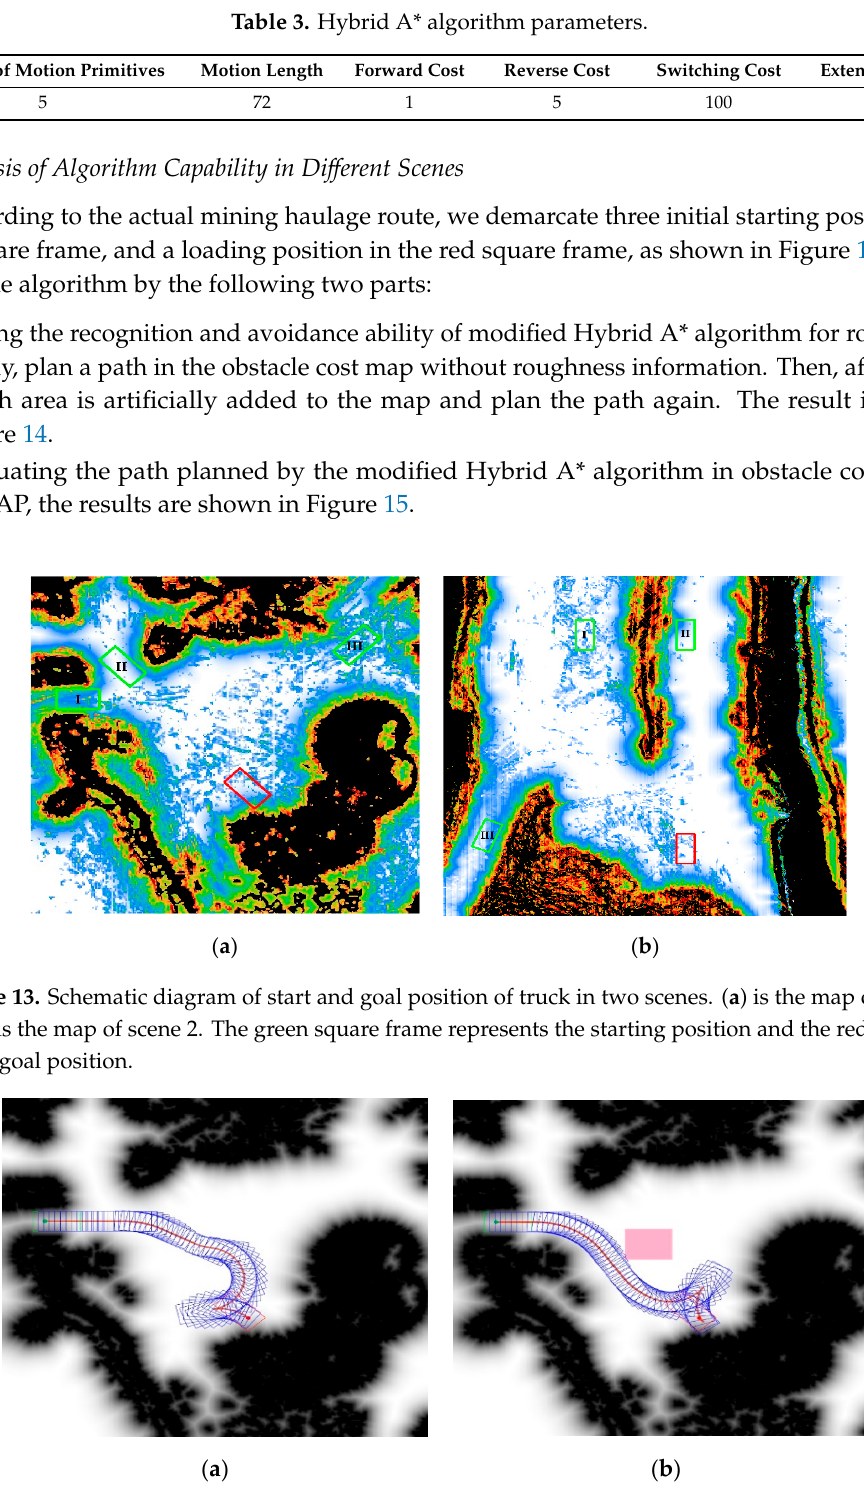
Figure 14. Schematic diagram of the roughness avoidance ability of the algorithm. ( a ) is the planning path in the OCM; ( b ) is the planning path in the OCM with the virtual rough area (pink